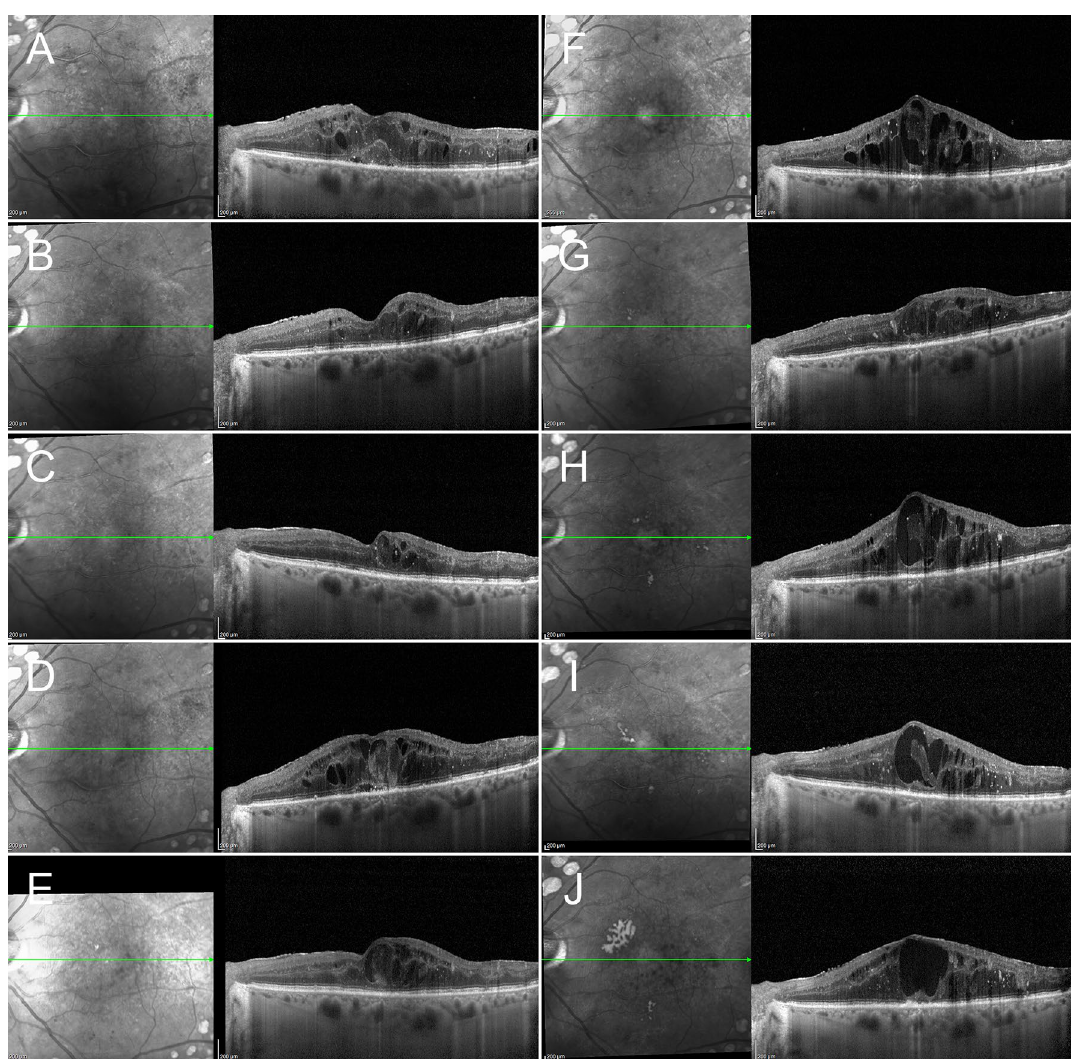
Figure 6. The possible pathogenesis of foveal eversion in diabetic macular edema. The starting condition is a DME ( A ) responding to intravitreal treatments, with recurrence/persistence of clinical behavior ( B , C ). The persistence of the intraretinal fluid leads to a progressive disorganization of both inner and outer retinal layers ( D , E ). Although the amount of DME in the recurrence ( D ) is similar to the baseline condition ( A ), its recurrence occurs in the context of a more disorganized retina, showing increased intraretinal hyperreflective foci and vertical linear mixed reflectivity signals in the context of the edema, which might be interpreted as a gliotic reaction of the foveal Muller cells ( D ). The subsequent partial regression of the edema ( E ) is characterized by still higher intraretinal disorganization than the previous similar partial regression ( B ). Foveal eversion then appears ( F ), in this case categorizable as Pattern 1b (multiple transretinal thin lines). The onset of foveal eversion occurs together with a focal central disruption of the ellipsoid zone, highlighted by choroidal hyper- transmission detected on structural OCT ( F , G ). In later stages, progressive degenerative phenomena occur within the foveal region ( H , I ), leading the condition to evolve into a Pattern 2 foveal eversion (no signs of transretinal vertical material) and further disruption of the ellipsoid zone ( J